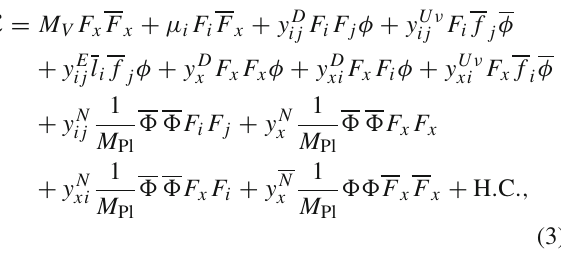
/ N (and N c x ) are very heavy from Eq. (3). Also, the x